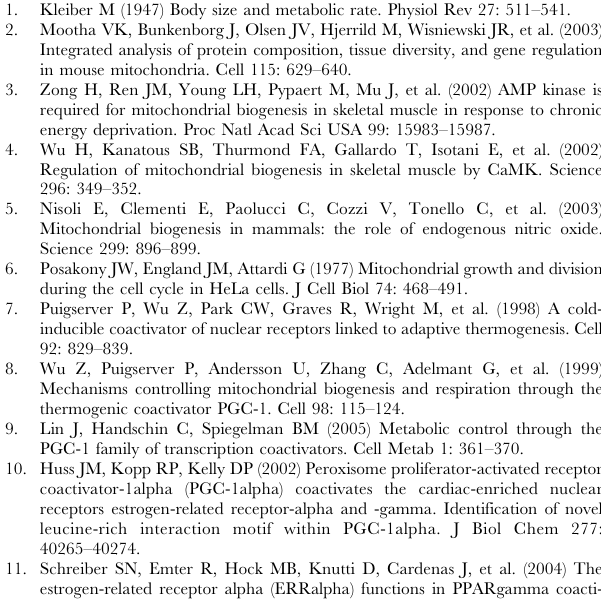
Figure S5 Basal and uncoupled respiration in confluent 3T3-L1 preadipocytes upon BRD6897 treatment for 3 days. Differences between DMSO and BRD6897 treatment groups were determined by ANOVA with Bonferroni’s multiple comparison test. * p , 0.05, ** p , 0.01, *** p , 0.001. (TIFF) Figure S6 Changes in mitochondrial protein turnover upon BRD6897 treatment as detected by pulse-chase labeling. HUVEC were treated with either DMSO or 10 m M BRD6897 for 2 days. Cells were then ‘‘pulse’’ labeled with methionine/cysteine for 2, 4, or 6 hours (left panel). Following 6 hours of labeling, the label was ‘‘chased’’ for 1, 3, or 6 days (right panel). Cytochrome C from protein lysate was immunoprecipitat- ed and run on an SDS-PAGE gel. (TIFF) Methods S1 Additional details for secondary assays, oxygen consumption assay, transmission electron microscopy, and pulse- chase labeling and immunoprecipitation.